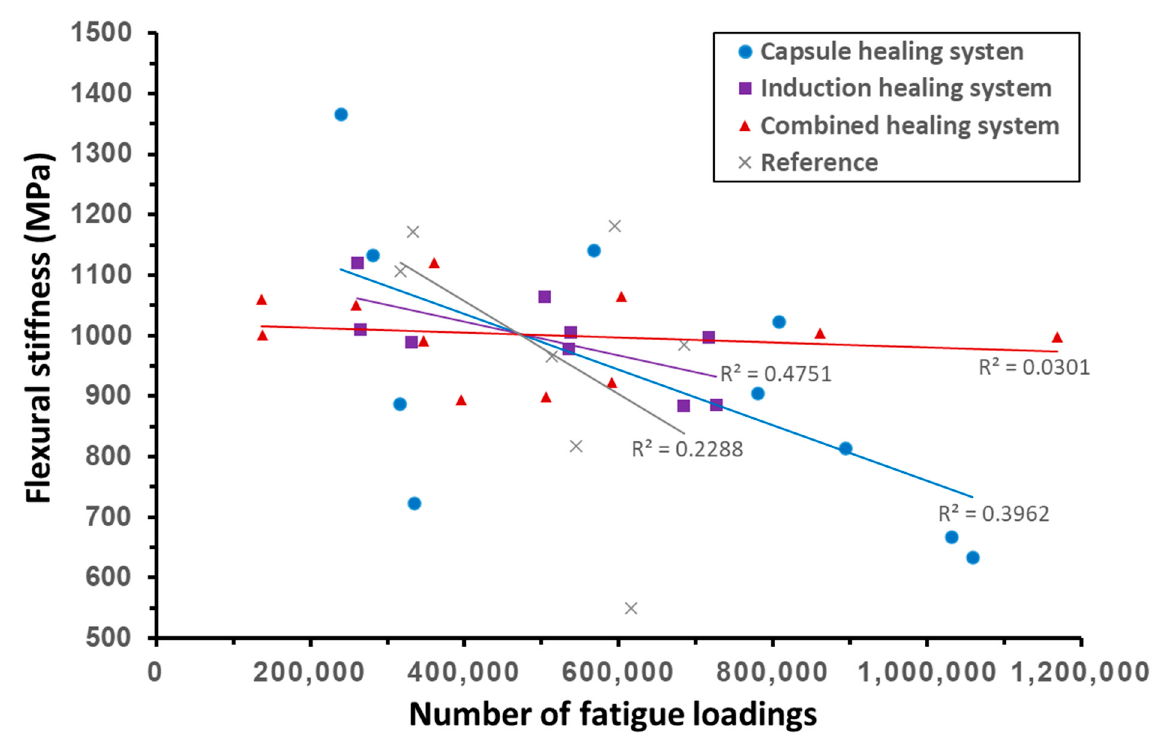
Figure 17. Development of flexural stiffness for the various healing systems.